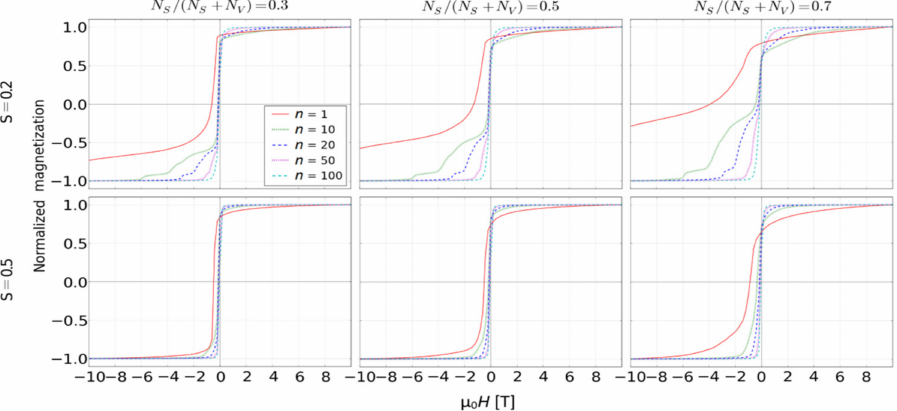
Figure 6. Simulated reverse magnetization curves for the systems with K S = 5 × 10 − 4 eV, K V = 0 eV and S = 0.2 as well as S =